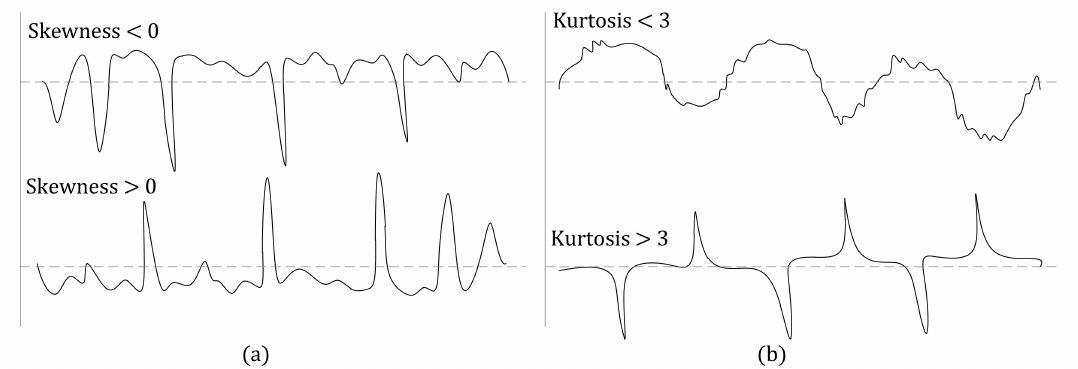
Figure A1. Schematic presentation of roughness profiles for ( a ) positive and negative skewness and ( b ) kurtosis lower and higher than